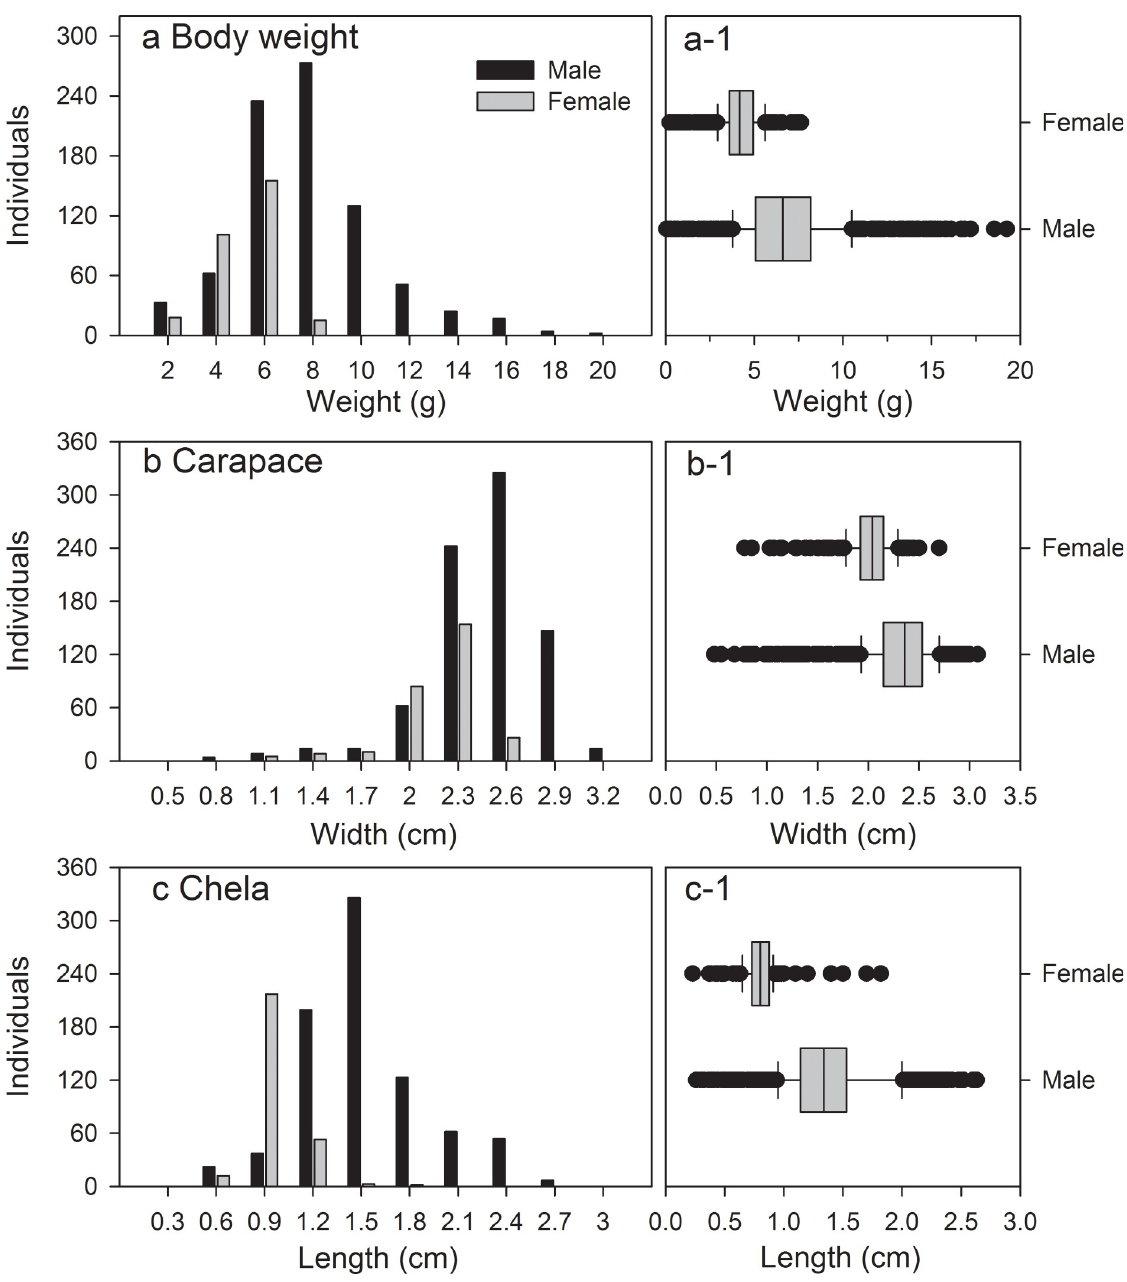
Fig 7. A survey of the distribution of female and male morphological measurements for the all crabs, wet body weight (a), carapace width (b), and chela length (c).